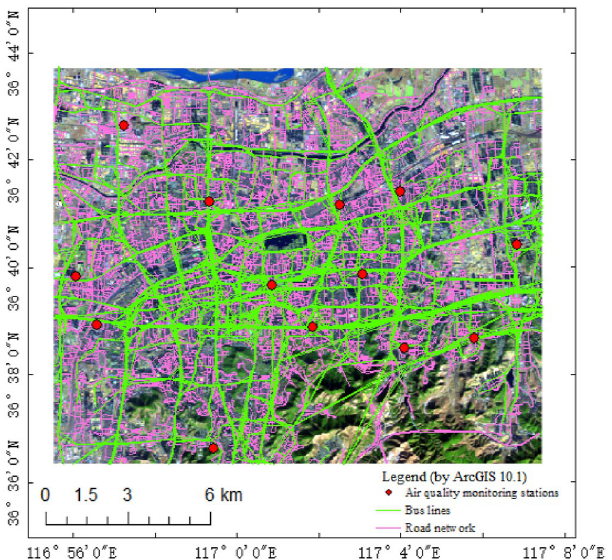
Figure 2. Air quality monitoring stations, bus lines, and road network in the study area. The red dots are the air quality monitoring stations; the green lines are the bus lines and the pink lines are road network. Map created in ArcMap 10.5 of the Environmental System Resource Institute, Inc. (https:// www. esri. com/ softw are/ arcgis/ arcgis- for- deskt op).